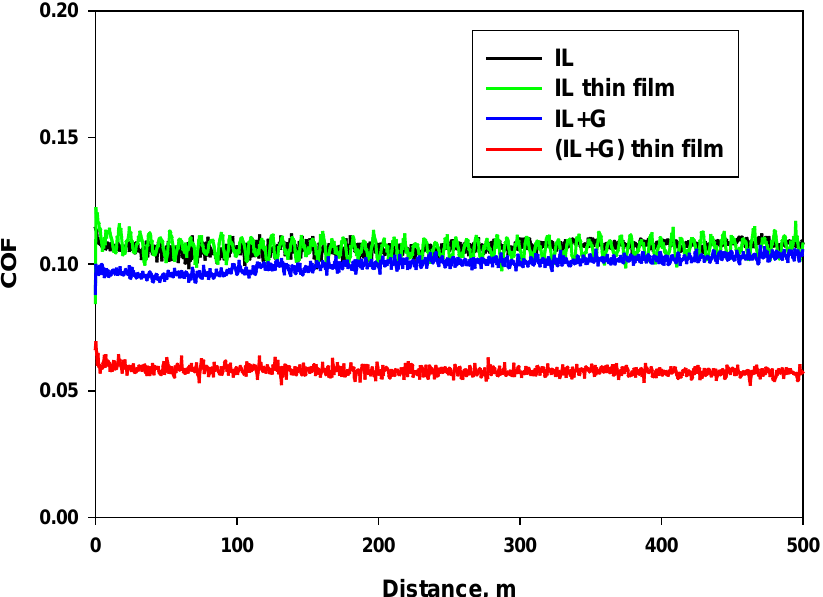
Figure 3. Coefficient of friction vs. sliding distance records for each lubricant.